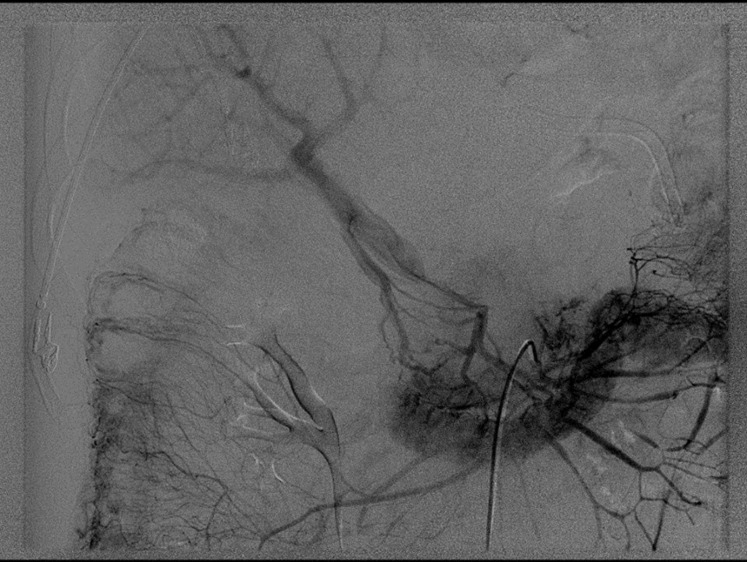
Splenoportography (venous phase) showing absence of venous return via the superior mesenteric and splenic veins, with drainage via collateral veins.